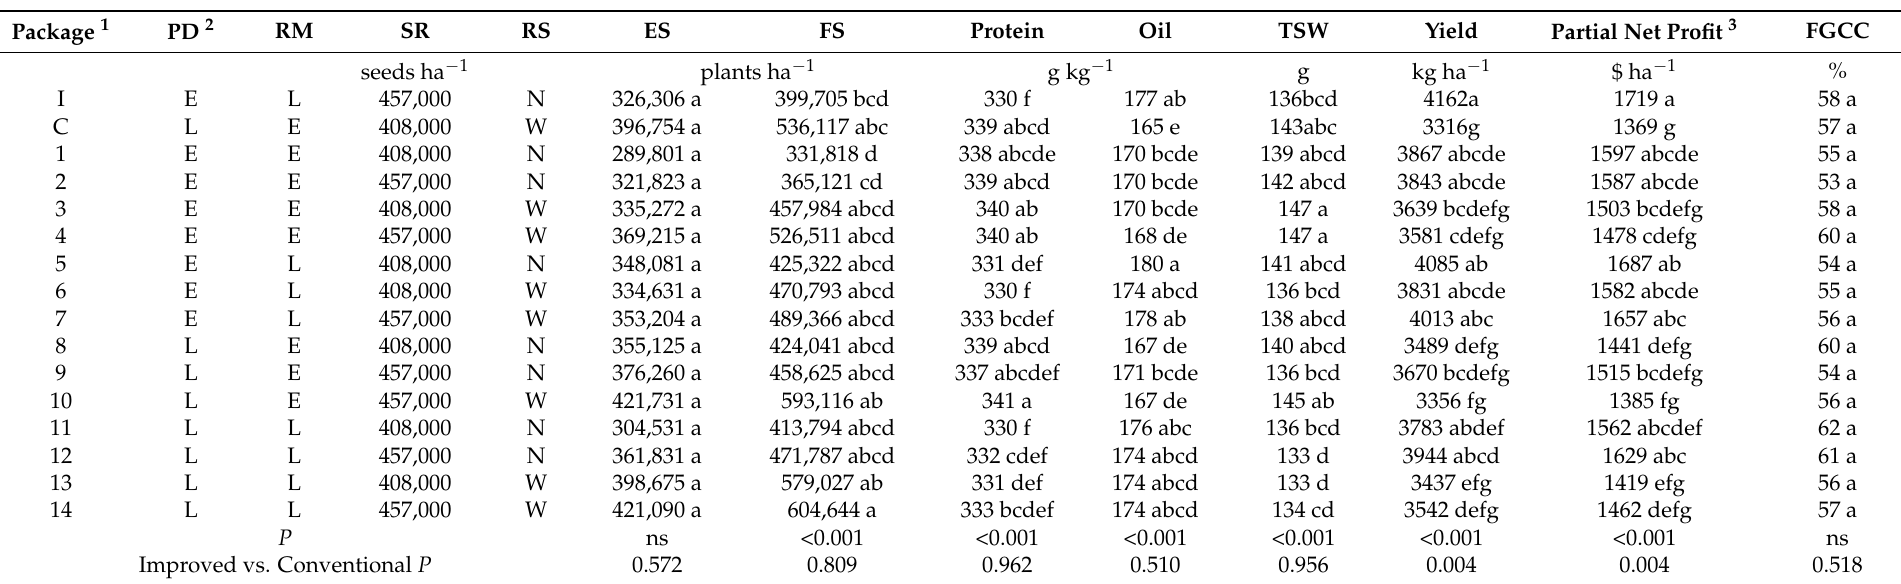
Table 6. Treatment package means and contrasts for soybean agronomic characteristics and partial net averaged across environments in 2019 and